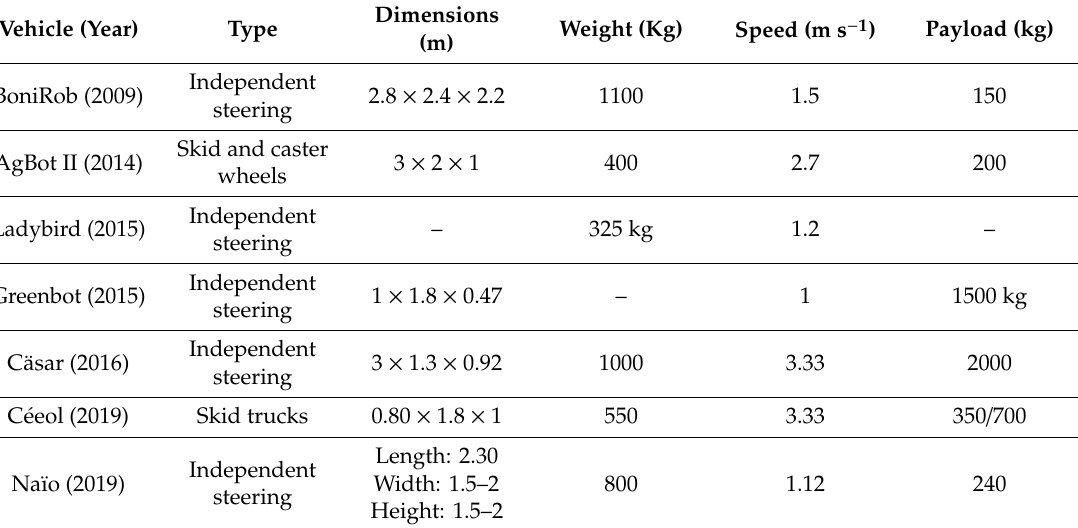
Table 5. Main characteristics of current mobile